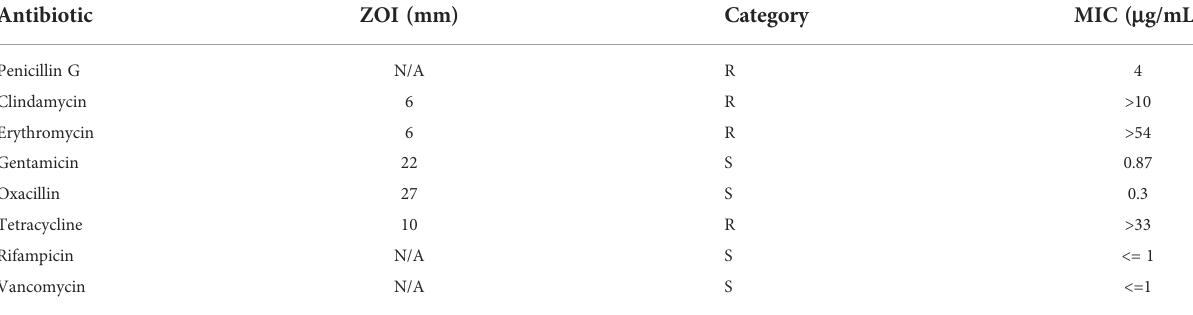
TABLE 1 Antimicrobial Susceptibility of SA ST398